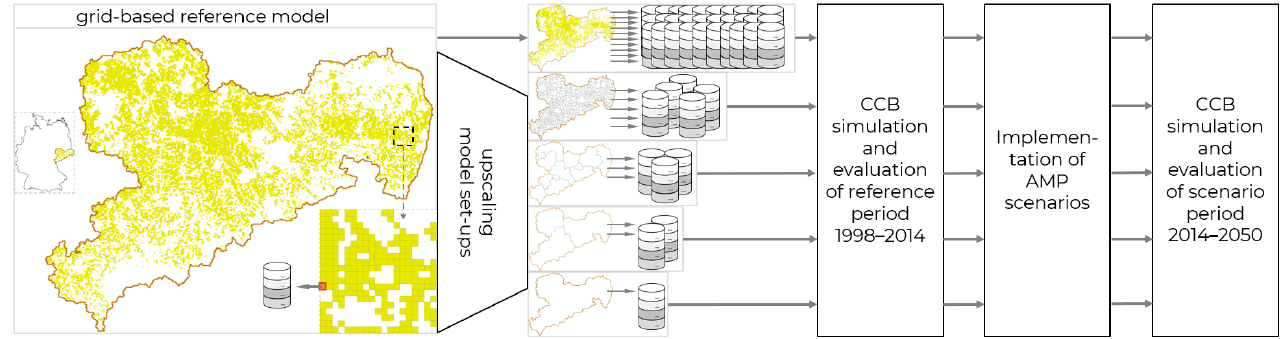
Figure 1. Workflow for assessing the SOC dynamics of arable land of Saxony and the carbon sequestration potential of alternative management practices (AMP) across a series of scales. Upscaled model set-ups on four different administrative levels of Europe (NUTS1, NUTS2, NUTS3, and LAU) were evaluated against the simulation results of a 500 m grid-based reference model.